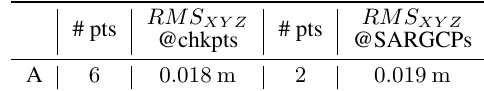
Table 1. Precision of GNSS measurements of selected ground control and check points in test area A For the GNSS measurements of the geodetic SAR points